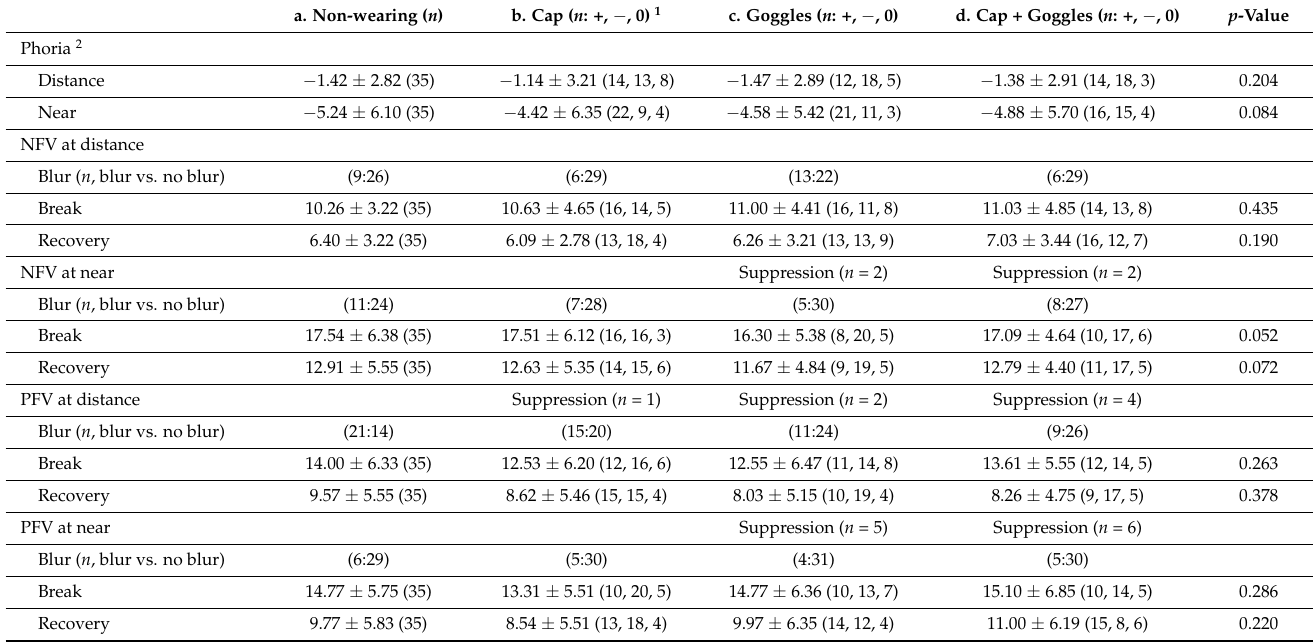
Table 3. Differences in phoria and fusional vergence between wearing and non-wearing of swimming cap and